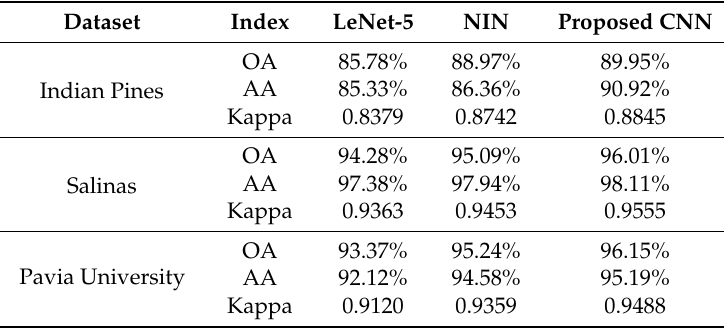
Table 9. Classification results of different CNN architectures on three HSI datasets.